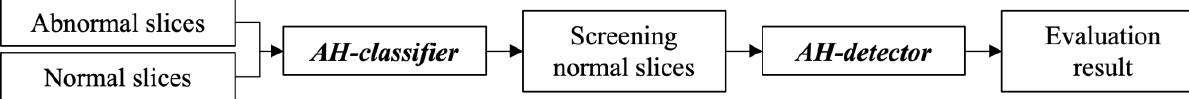
Figure 3. Flow of AH lesion detection using AI models.